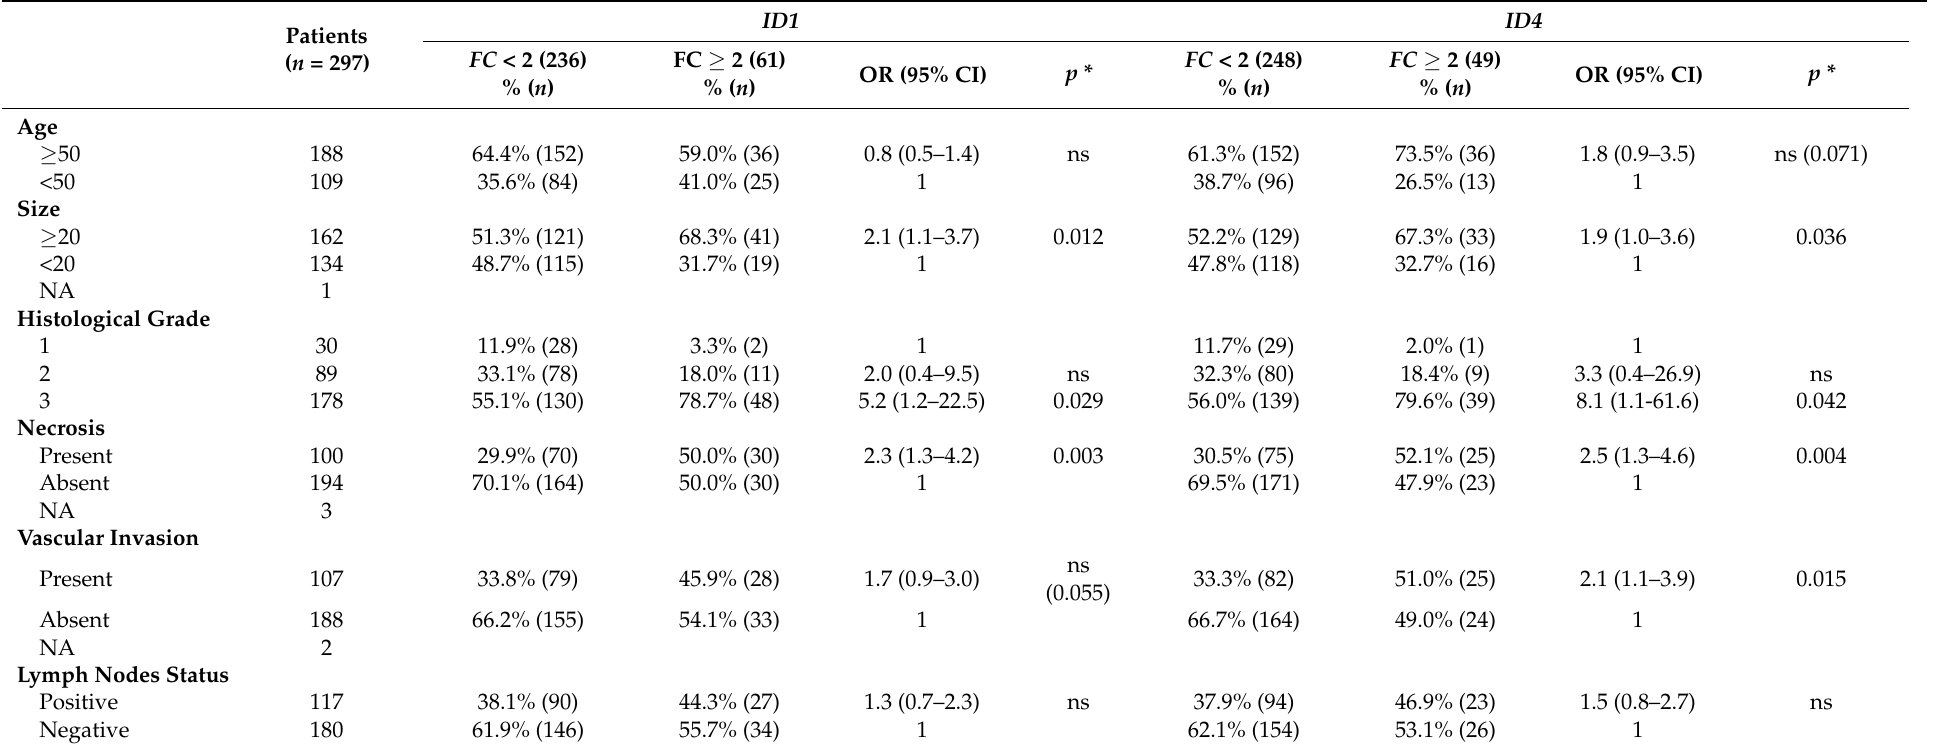
Table 1. Correlation between ID1 and ID4 mRNA expression and clinicopathological